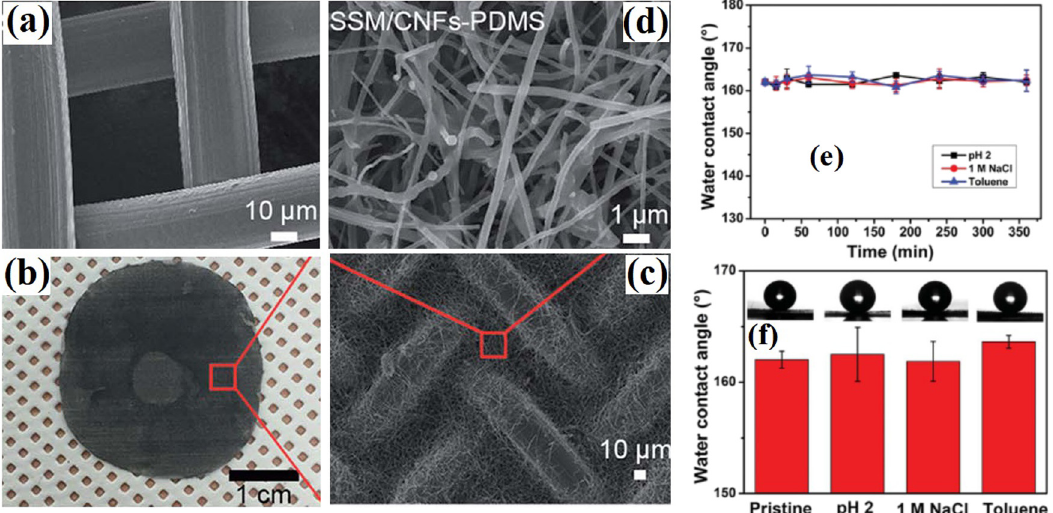
Figure 12: SEM images of ( a ) SS mesh and ( c, d ) SS mesh/CNF/PDMS composite membrane. ( b ) Photograph of the composite membrane. CA variation with ( e ) time and ( f ) after 15 days of corrosion test [ 255 ] . Reproduced with permission from ref. [ 255 ] ; © 2016 The Royal Society of